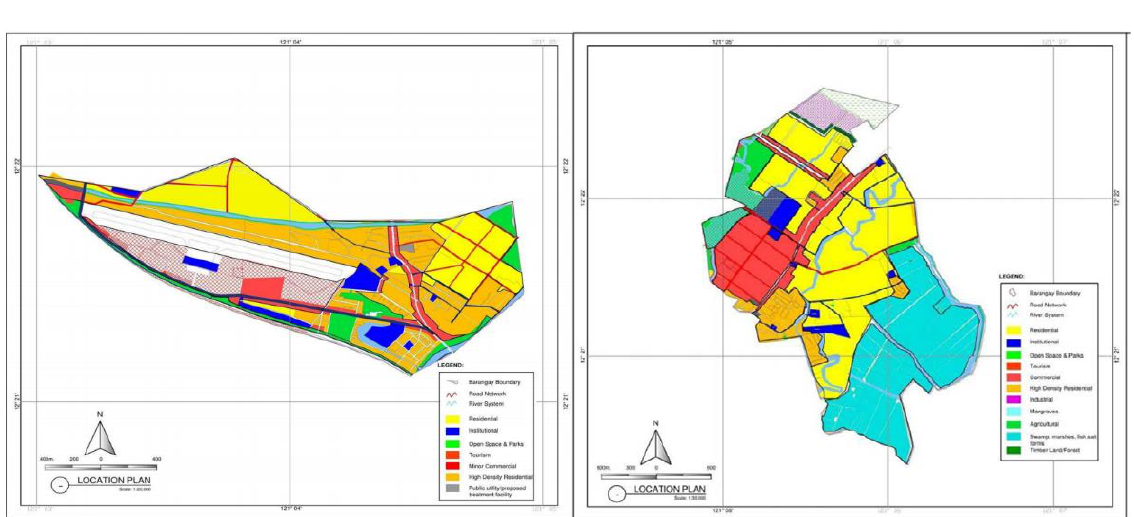
Fig. 2 : General land use map of (a) San Roque (b) Labangan Poblacion (LGU San Jose, 2017)